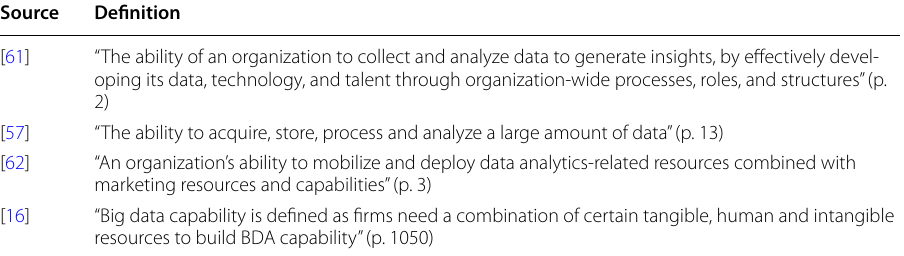
Table 10 Big Data analytics capability